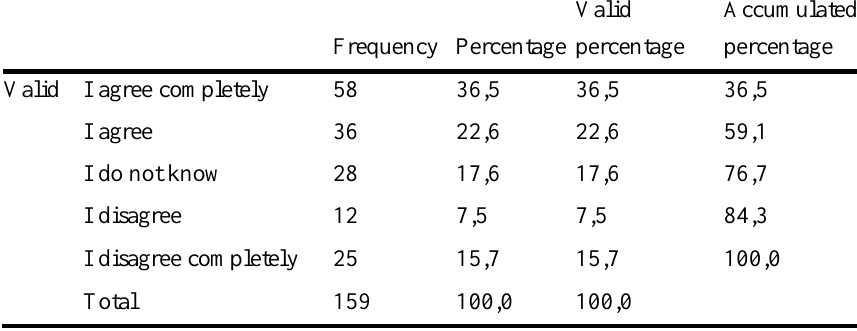
Valid percentage questionnaires´ results, question 8 “Bilingual lessons are accessible to